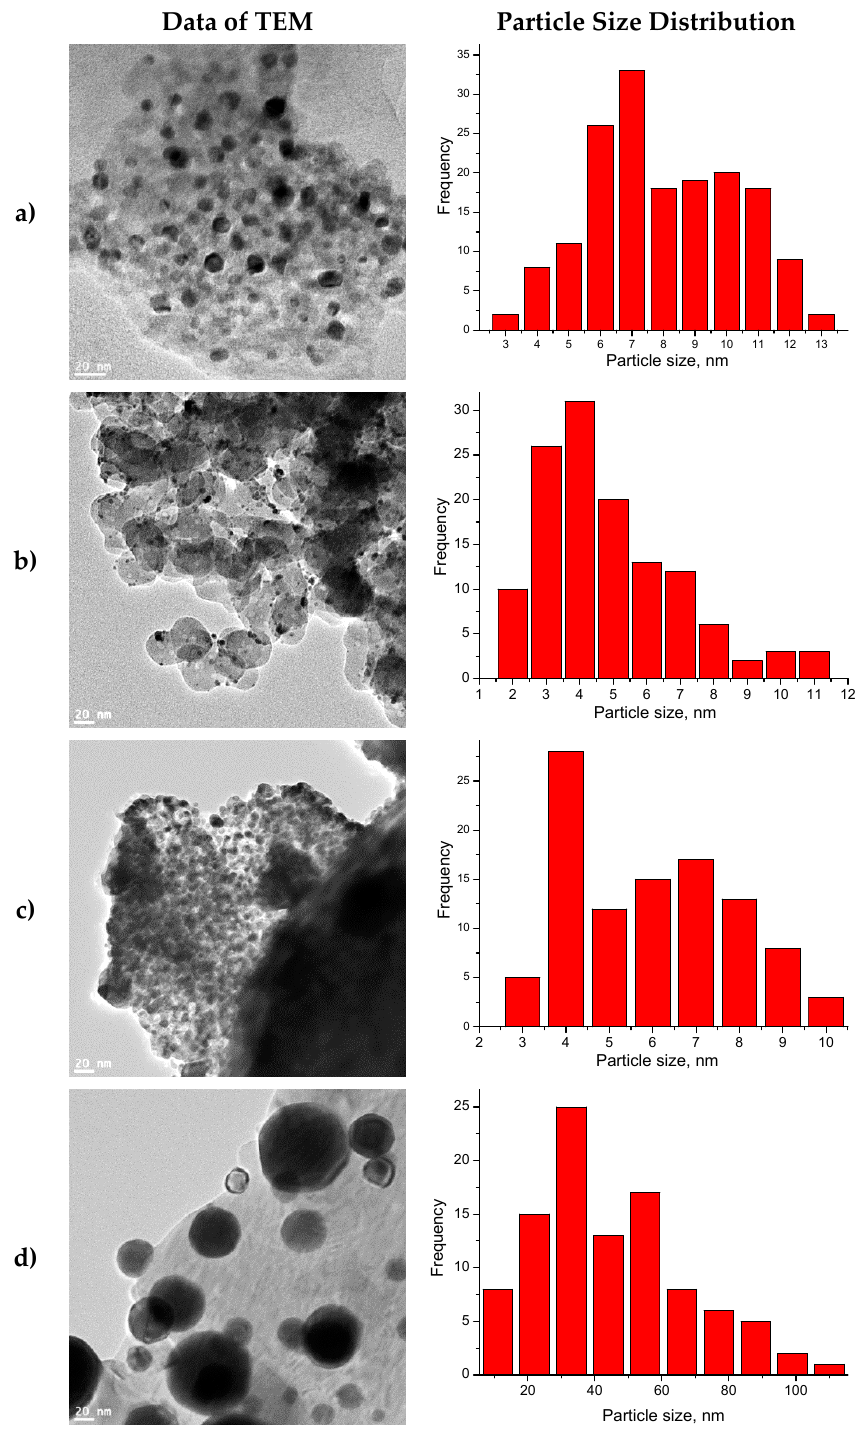
Figure 5. TEM images of catalysts and particle size distribution: ( a ) 5 wt.% Pd/ γ -Al 2 O 3 ; ( b ) 5 wt.% Pd/SiO 2 ; ( c ) 5 wt.% Pd/SiO 2 -C 3 H 6 -NH 2 ; ( d ) 5 wt.% Pd/C.